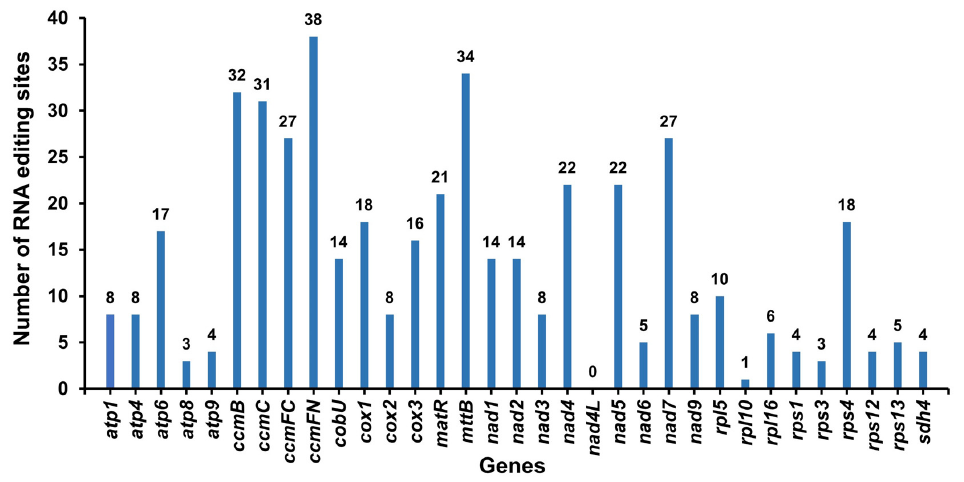
Figure 6. Characteristics of the RNA editing sites identified in PCGs of the C. speciosa mitochondrial genome. The names of the protein-coding genes are displayed on the X-axis, and the number of RNA edits of the protein-coding genes is displayed on the Y-axis.